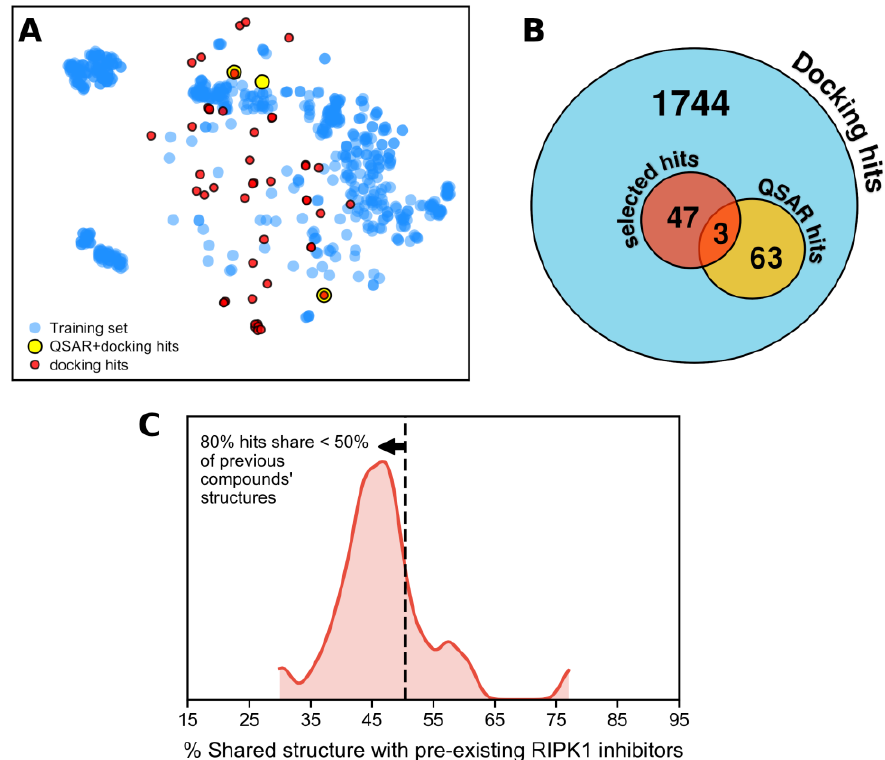
Figure 15. ( A ) Distribution of the 50 in silico hits (yellow and red) with respect to the RIPK1 inhibitors dataset (blue). ( B ) Overlap of subsets of in silico hits obtained, resulting from Docking predictions and machine learning QSAR predictions. ( C ) Quantifying chemical novelty through the distribution of the percentage shared structure between the in silico hits and their closest compound in the RIPK1 inhibitors dataset.